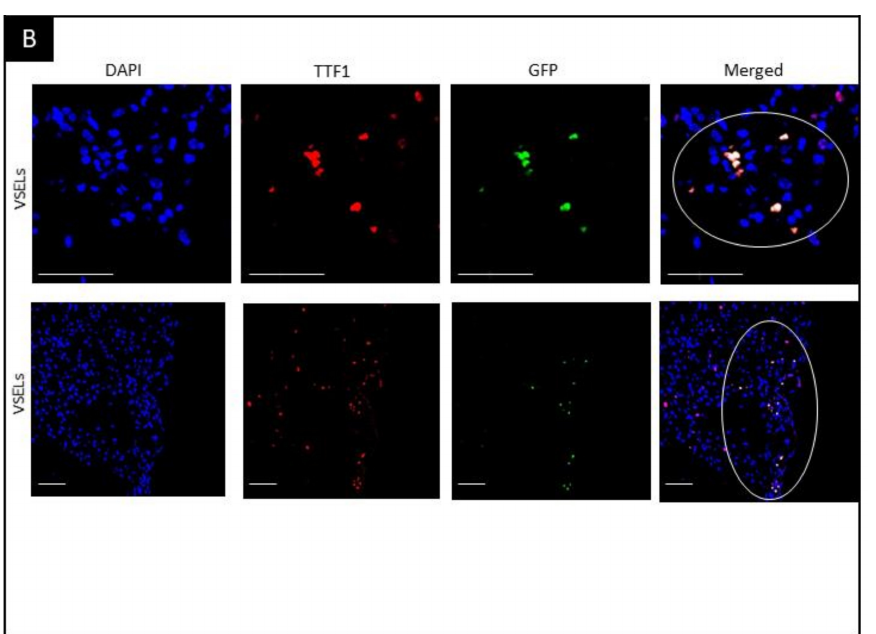
Figure 4. Visualization of GFP + /TTF1 + AT2 cells in transplant recipients. Fluorescence microscopy on paraffin embedded lung tissue sections. Blue—DAPI, Green—GFP, Red—TTF1, and merged colors. Scale bars represent 100 µ m. Panel A : Top row: colocalization of DAPI, GFP and TTF1 indicates AT2 cells. Second row: GFP + AT2 cells derived from GFP-positive donor VSELs cells. Third and fourth rows: no GFP + cells. Olympus FluoView V1000 confocal microscope, 40 × original magnification (top and bottom row) and 42 × digital zoom (two middle rows). Panel B : representative images of clusters of GFP + /TTF1 + VSEL-derived AT2 cells. GFP + AT2 cell clusters in lung tissue from Bleo + /VSELs + recipients are marked with a circle. Olympus FluoView V1000 confocal microscope, 45 × and 20 × original magnification (upper and lower rows,